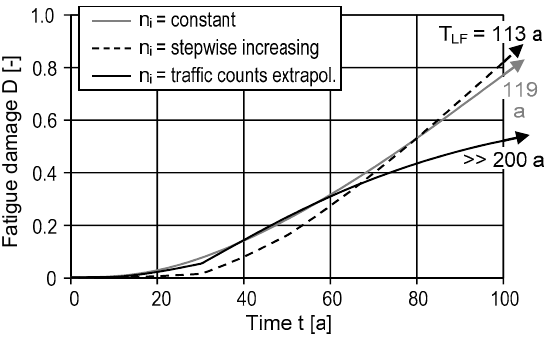
Figure 6. Damage evolution from a deterministic model with time-dependent stress ranges and three different approaches of the load frequency.